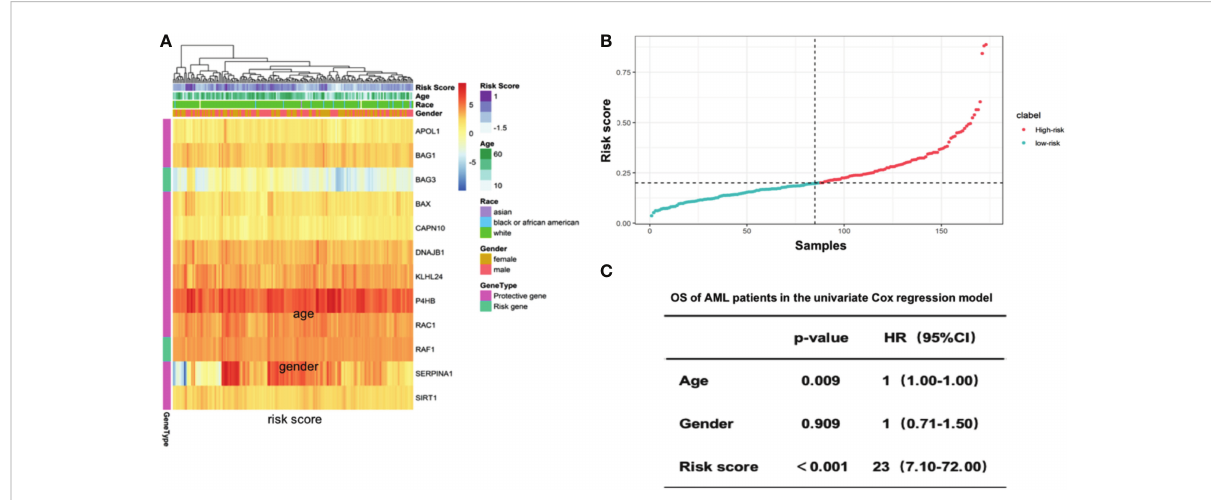
FIGURE 3 Risk score of 12 selected autophagy-associated genes is an independent predictor of patient survival in the AML cohort. (A) Heatmap showing the gene expression of the 12 selected autophagy-associated genes. Columns were annotated by patient race, gender and age. (B) Rank of risk scores in AML patients who were divided into high-risk and low-risk groups by the median value of risk score. (C) Multivariate Cox analysis shows the coef fi cients and corresponding p values in the model with risk score, age and gender as